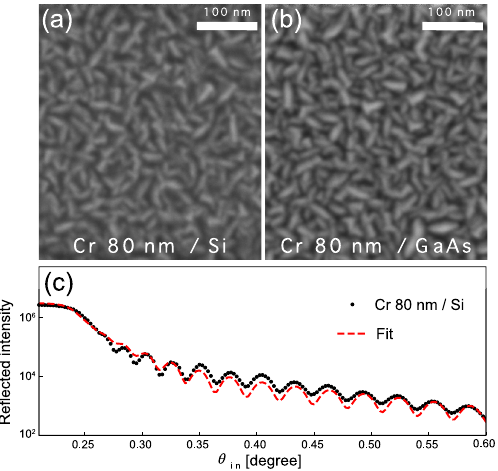
Figure 4. Scanning Electron Microscopy (SEM) images of 80 nm thickness of Cr film surfaces on the Si ( a ) and GaAs ( b ) as a substrate. ( c ) X-ray reflectivity measurement of Cr film on Si substrate with corresponding a model fitting. The interface roughness is estimated to be 10